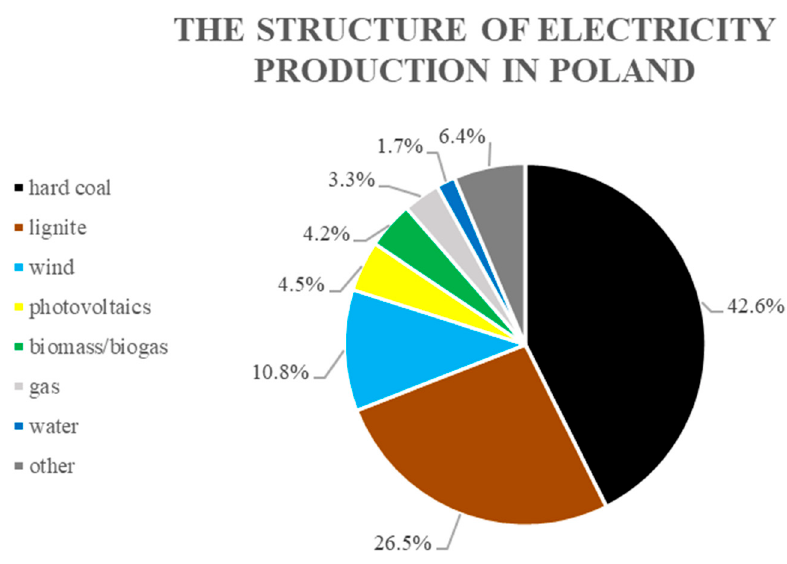
Figure 3. Structure of the electricity generation in all energy systems in 2022 in Figure 3. S tructure of the electricity generation in all energy systems in 2022 in Poland.